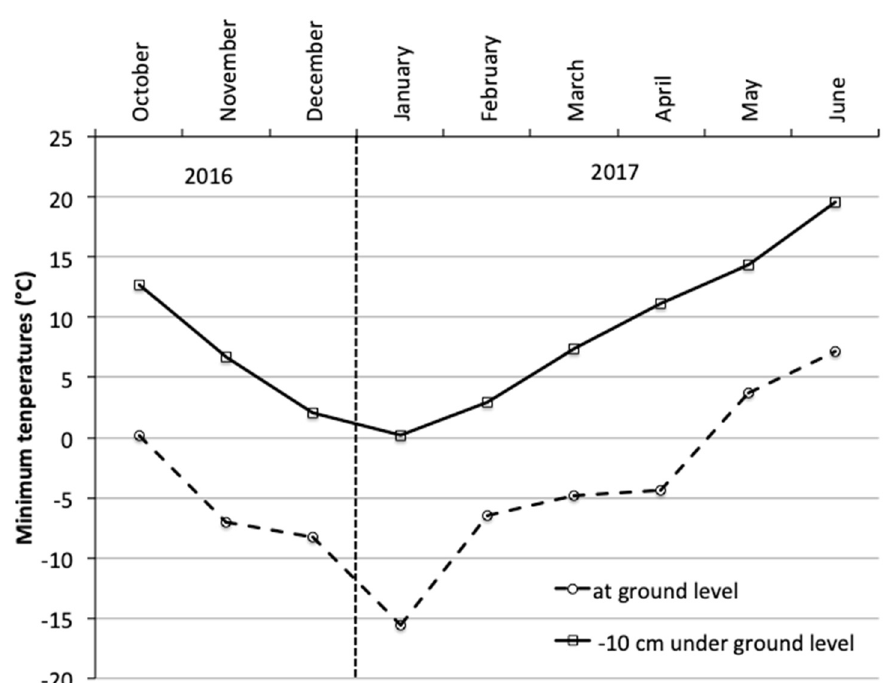
Figure 6. Minimum temperatures recorded during development of H. obsoletus nymphs on the roots of herbaceous host plants. In the winter period the nymphs live 20–25 cm underground, but in spring they move to ground level.